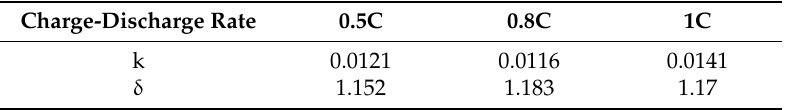
Table 4. Calibration results for parameters k and δ